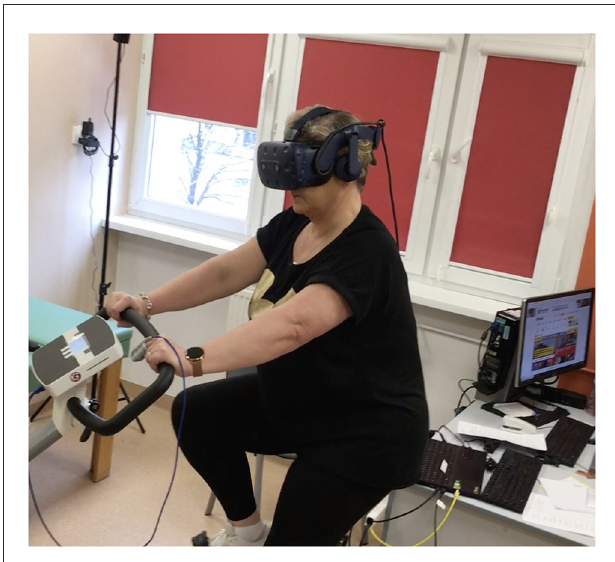
FIGURE1 Exercise training on cycle ergometer with VR.